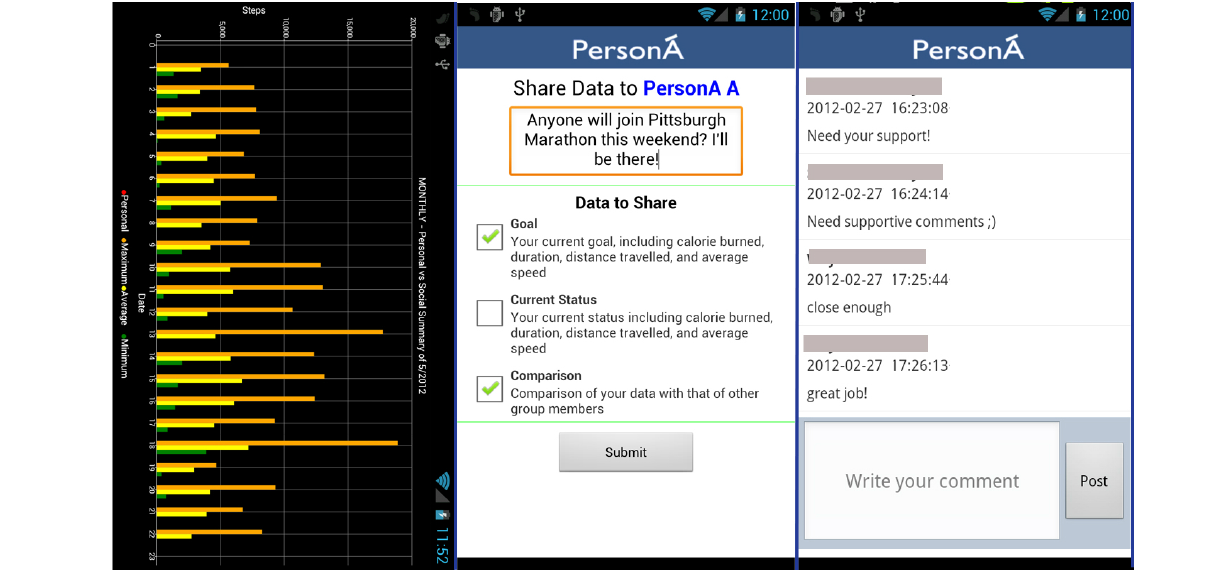
Figure 5. PersonA social support